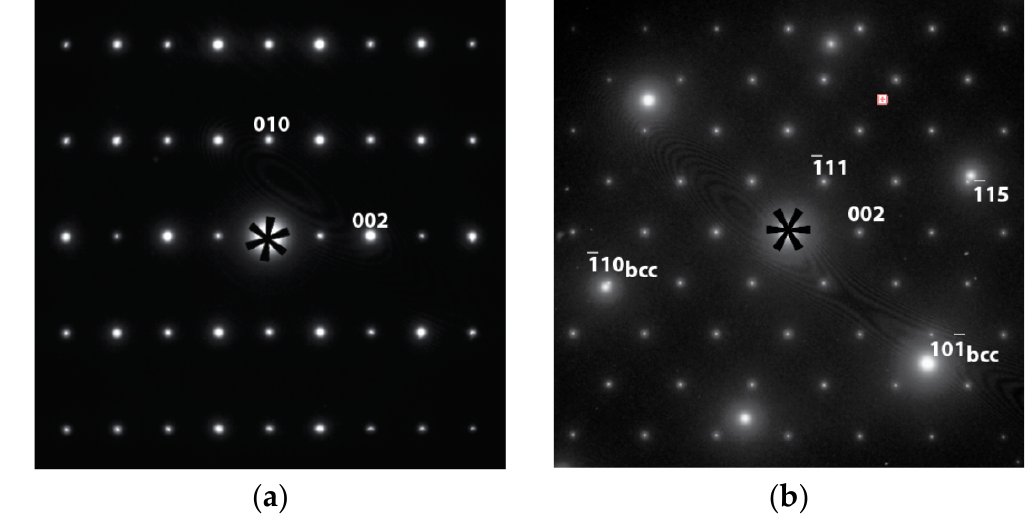
Figure 9. SAED patterns from Phase II of Alloy P7 that fit ( a ) a C14 structure in the [100] zone axis and ( b ) a face-centered cubic (fcc) structure with a ≈ 11 Å in the [110] zone.